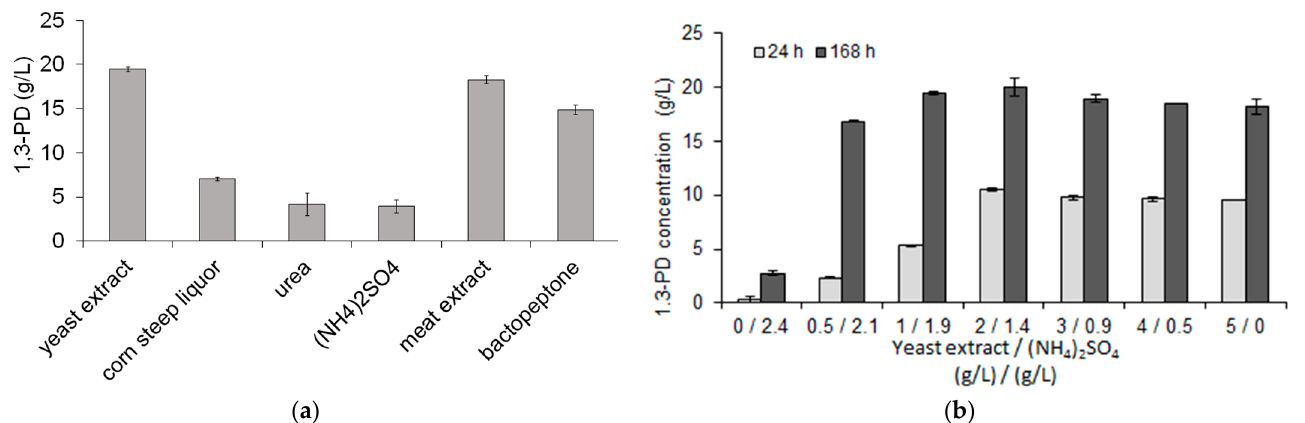
Figure 1. Influence of various nitrogen sources on 1,3-PD production ( a ) and effect of yeast extract replacement by (NH 4 ) 2 SO 4 on 1,3-PD production ( b ).